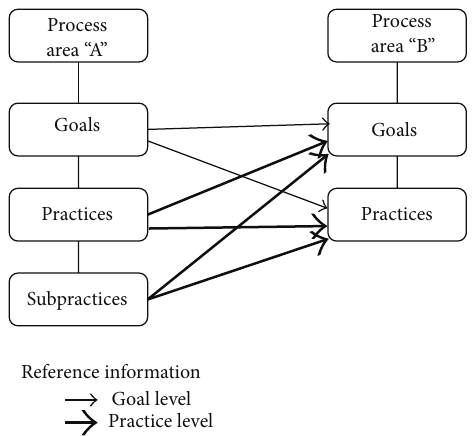
Figure 3: Structure of process areas in